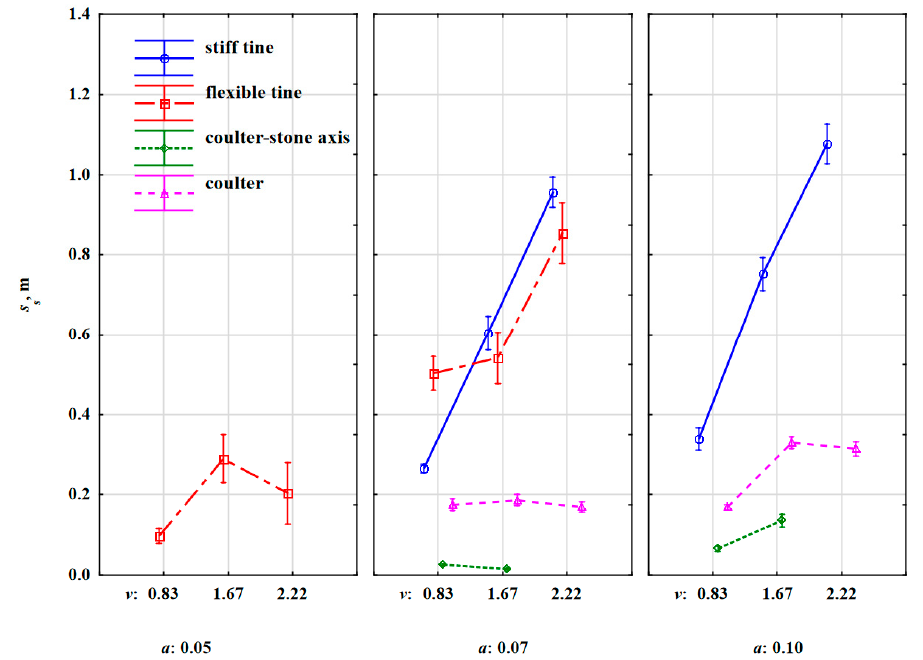
Figure 9. Stone displacement distance due to forces of the stiff tine, flexible tine, coulter-axis stones and coulter working at different working depths and speeds.